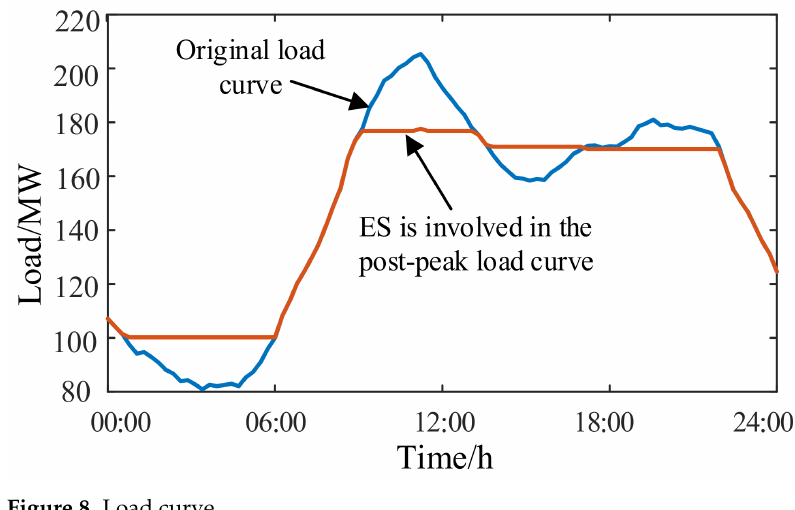
Figure 8. Load curve.